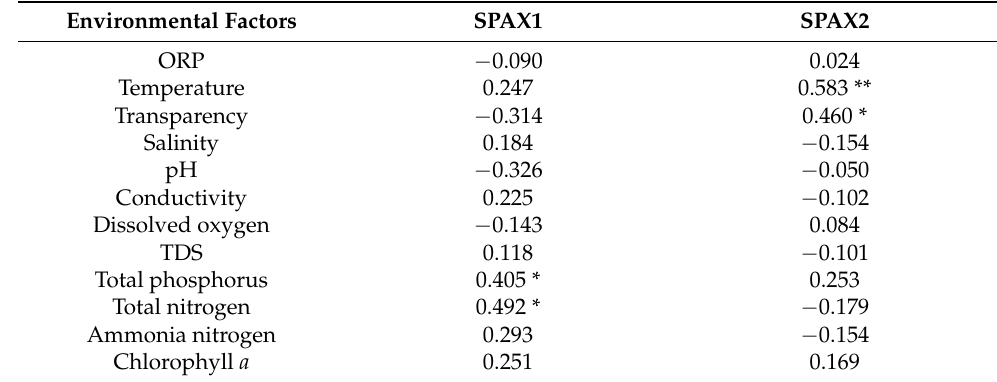
Table 3. Correlation coefficients for environmental factors with the main principal component axes of the abundance of Brachionus calyciflorus